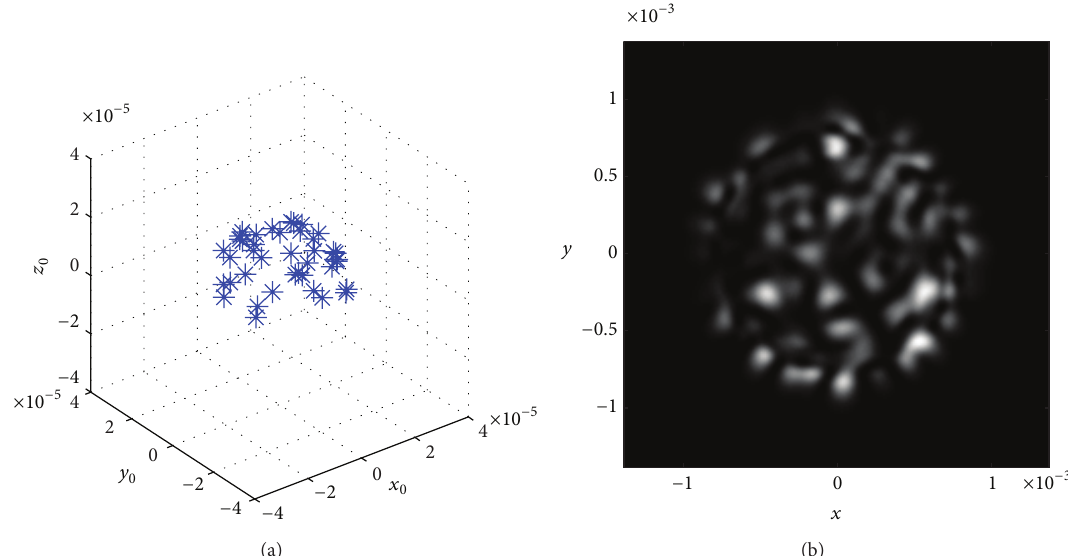
Figure 3: Half sphere composed of 40 randomly located Dirac emitters (a) and interferometric out-of-focus image created by this object (b). The radius of the half sphere is 20 micrometers. All axes are in meters.